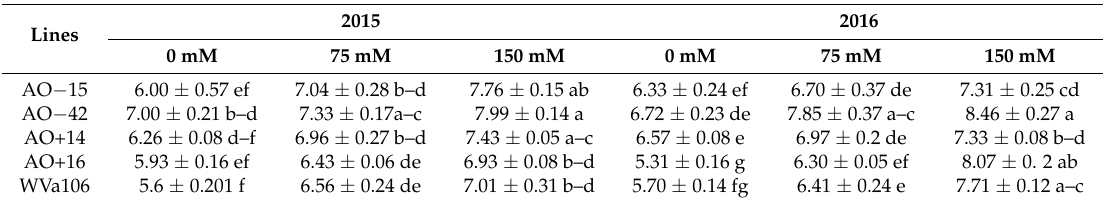
Table 4. Soluble solid content (%) of lines with low or elevated AO activity and non-transgenic line of red-ripe cherry tomato fruits under two salinity levels (75 and 150 mM NaCl) in 2015 and 2016. Results with the same letter were not significantly different ( p < 0.05) according to the classification obtained by the Duncan test.